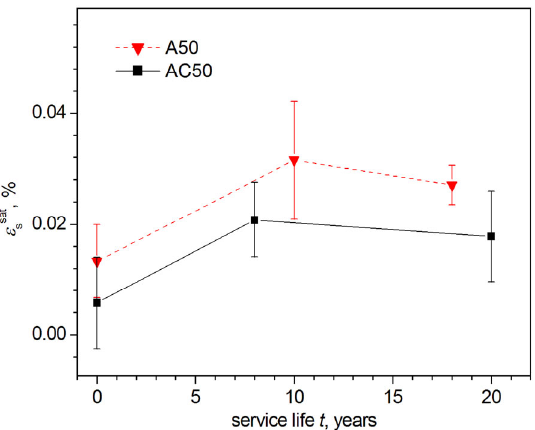
Figure 19. Microstrain ε ssat calculated under the assumption of a fixed crystallite size equal to the crystallite size D 12.5 μ m near the surface (at a depth of T ~ 12.5 μ m) depending on the service life t of the Al wires of the overhead power lines of the A50 and AC50 types (correspondingly, AAAC and ACSR types, without and with steel cores).